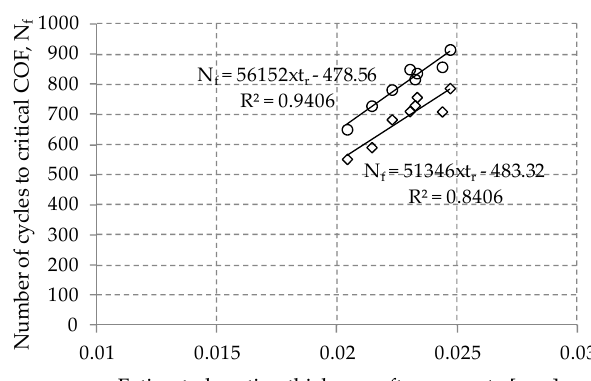
Figure 10. Relation between number of cycles to the critical friction coefficient (COF) and the estimated coating thickness after indentation creep. Smooth lines are fitted curves. The COF of 0.35 presents the beginning of sudden increase after a steady state sliding, while the value of 0.5 indicates the final of the test.